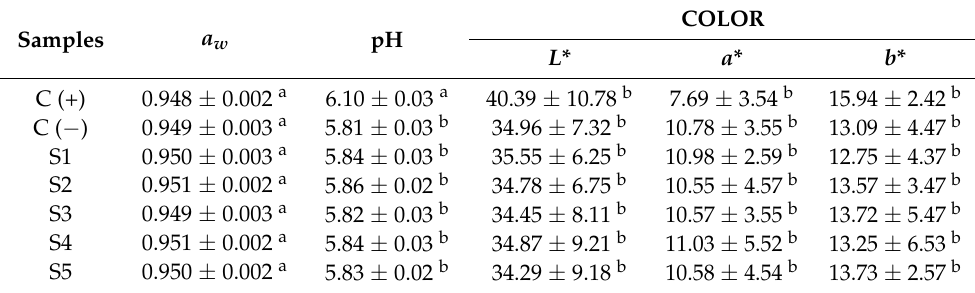
Table 2. pH, water activity ( a w ) and color of raw salmon burgers (mean ± SD). See Table 1 for details of the antioxidant composition in burger samples. Different letters mean significant differences for each parameter between burger groups after 14 days of storage at 4 ◦